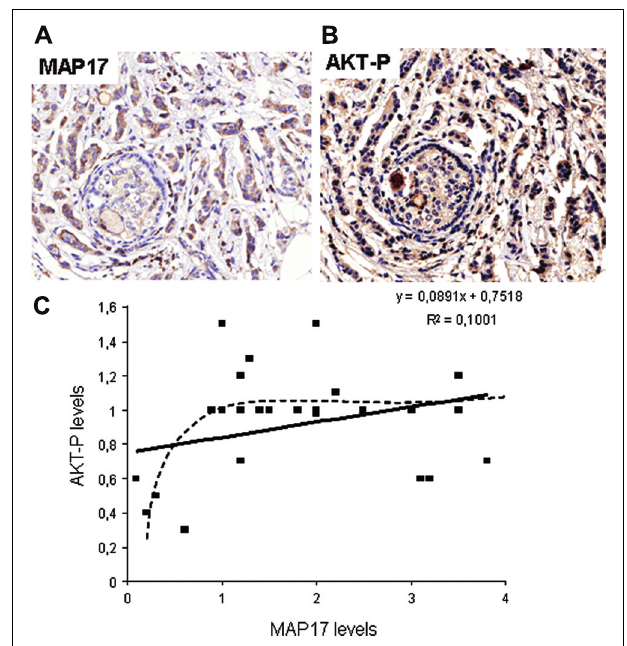
host elimination. Ectopic expression of MAP17 in tumor cells prevents TNF-induced G1 arrest by impairing p21waf1 induction.